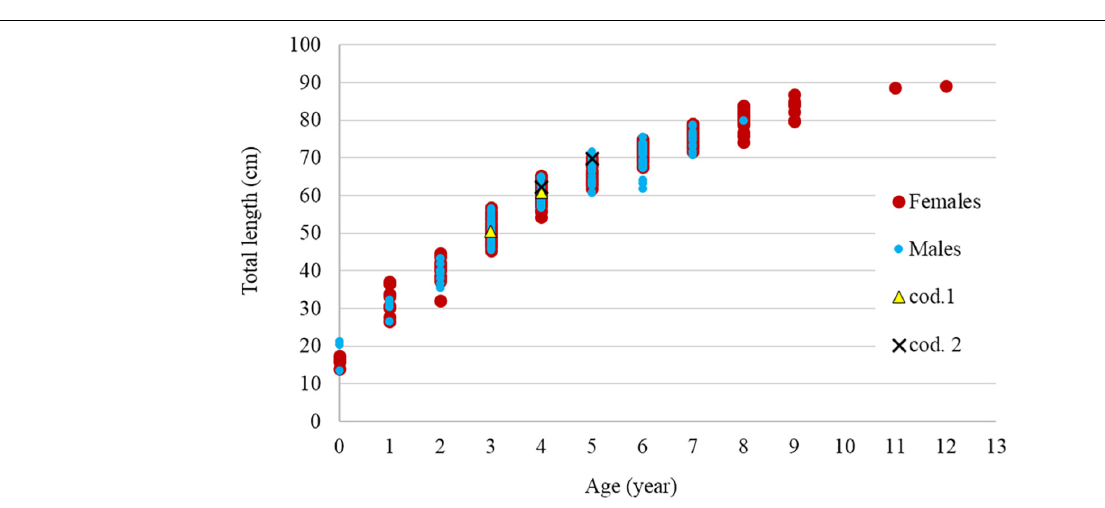
FIGURE 5 | Relationship between age and total length by sex. The two recaptured specimens (cod. 1 and cod. 2) are also